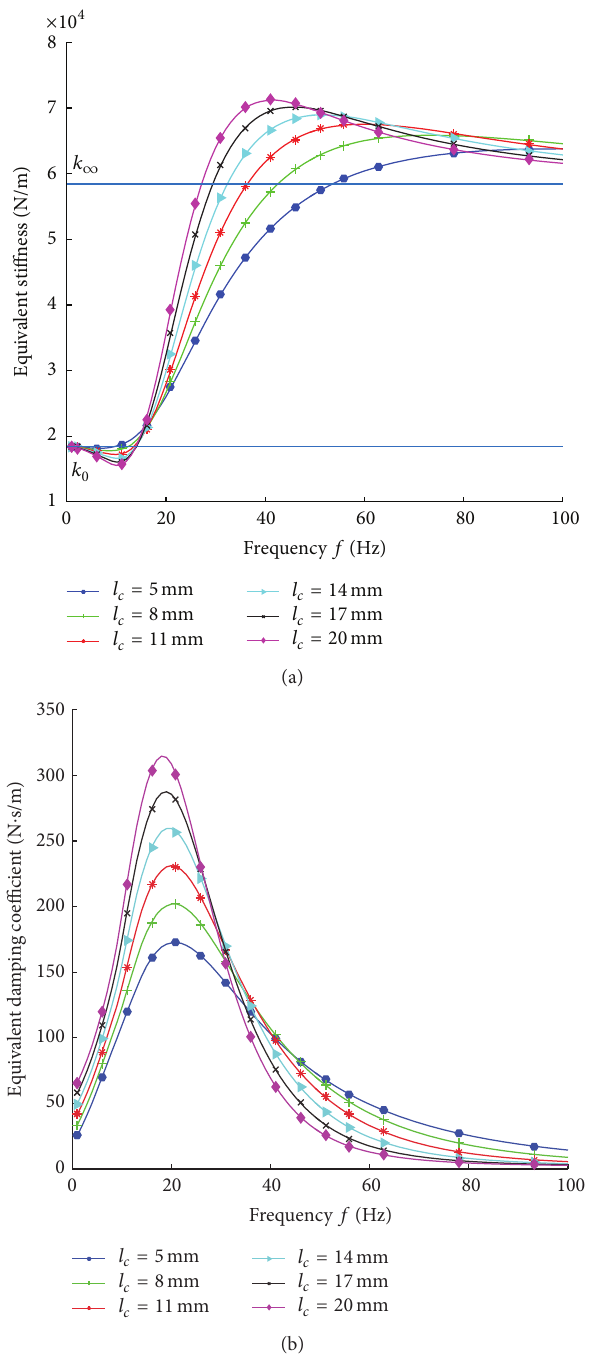
Figure 12: (a) Equivalent stiffness under different 𝑙 𝑐 values. (b) Equivalent damping coefficient under different 𝑙 𝑐 values.